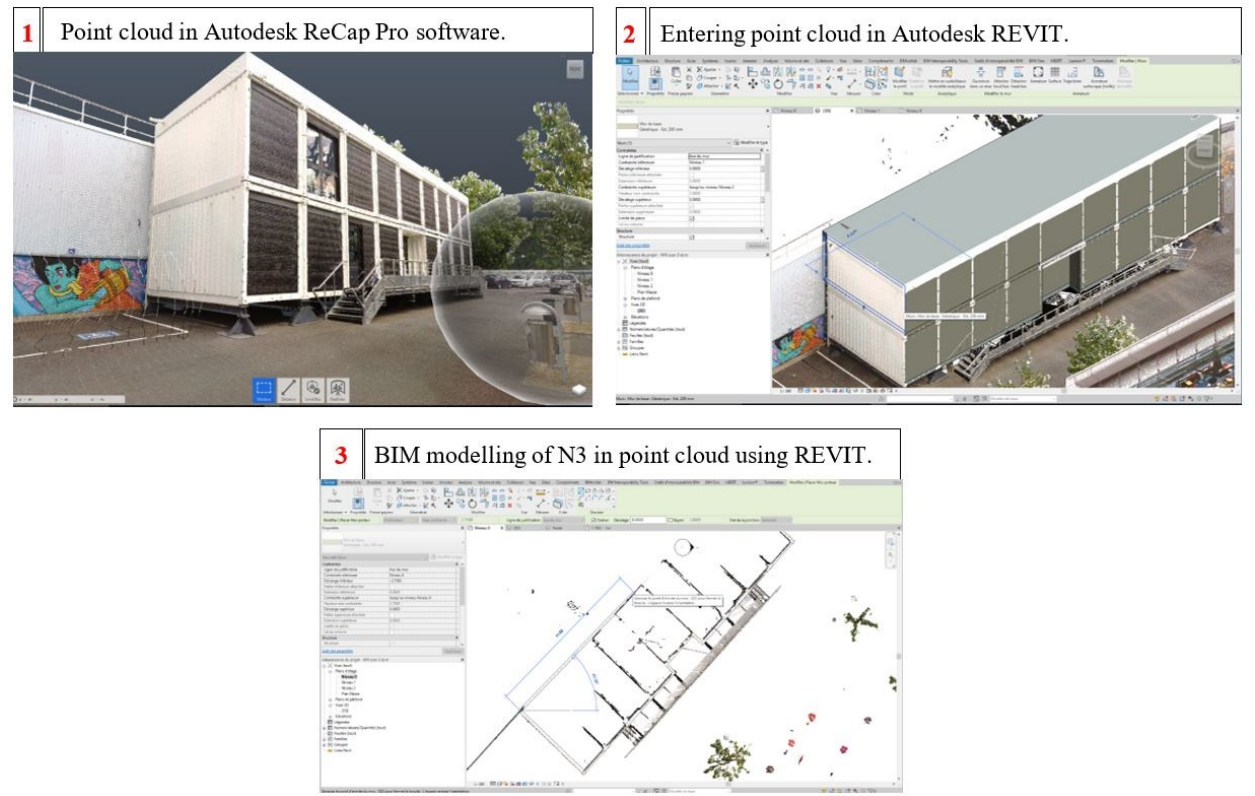
Figure 10. BIM modelling process for the CESI N3 building using a point